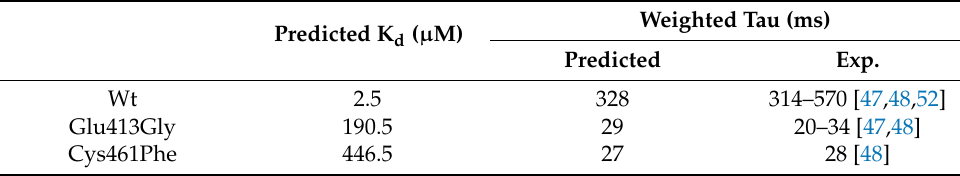
Table 1. Predicted K d and deactivation time constant for NMDA Wt and variants. Deactivation decay was fitted with a two-component exponential function, and the weighted Tau was then calculated (see methods Section 3.2.2).